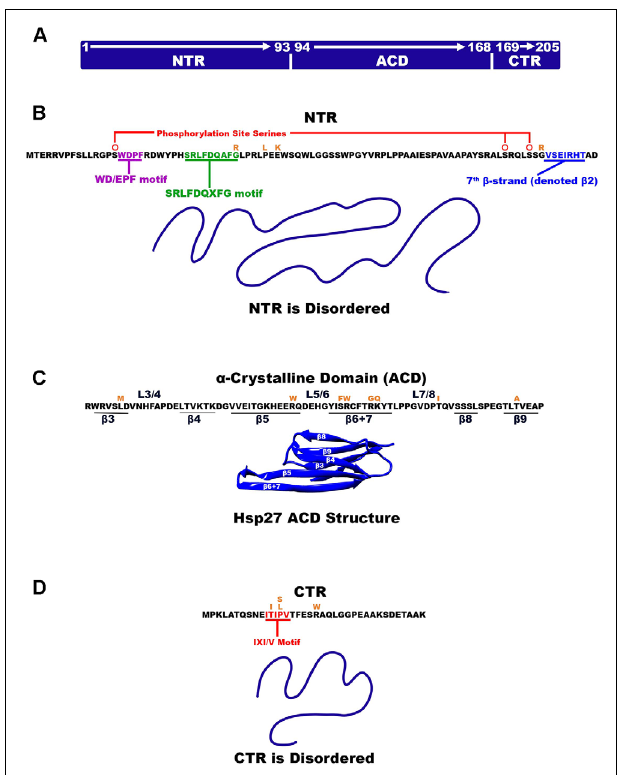
FIGURE 1 | Hsp27 Structural organization. (A) Hsp27 is made up of three regions where each region is identified as NTR, ACD, and CTR. The residue numbers that make up each region are also denoted. (B) The amino acid sequence of the disordered NTR is listed and the two motifs WD/EPF and SRLFDQxFG are highlighted with red and green, respectively. β -strand β -2 is highlighted in cyan. (C) The ACD amino acid sequence is listed as well as the location of β -strands and their connecting loops. The ACD is the only part of Hsp27 that is ordered (PDB 2N3J). (D) Hsp27 disordered CTR highlighting the IXI/V motif in red. Amino acid mutations are illustrated in orange above the amino acid being mutated.